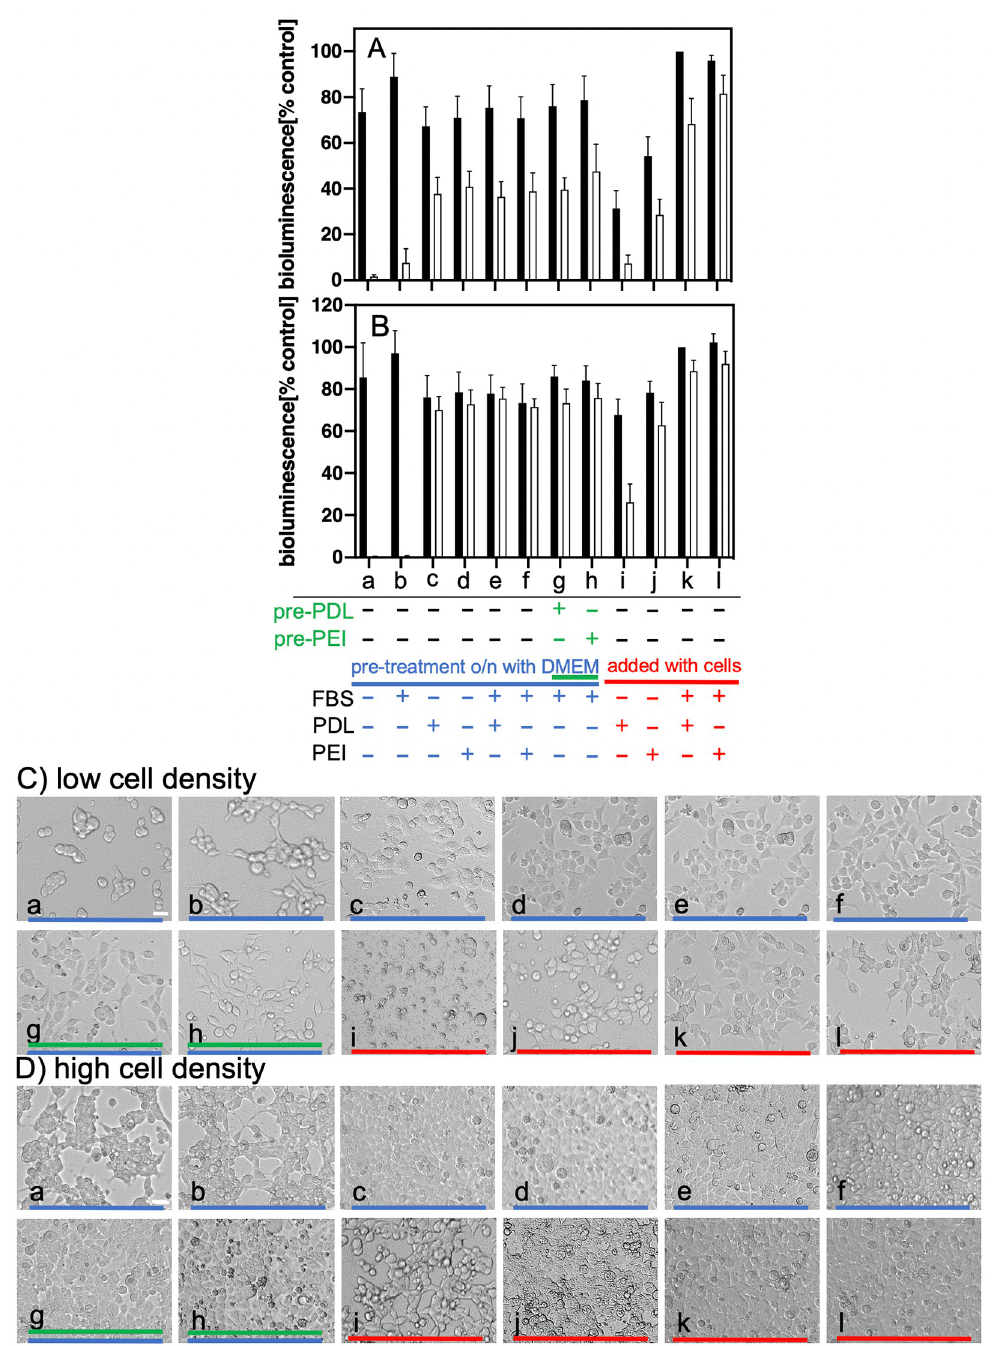
Fig 5. Fetal bovine serum not required for strong cell adhesion after PDL or PEI pre-treatment. Wells were pre-treated overnight with medium without or with addition of fetal bovine serum (FBS), PDL (2 μ g/ml), or PEI (1.5 μ g/ml) as indicated. Some wells were first pre-treated 1 h with either PDL (100 μ g/ml) or PEI (10 μ g/ml) (pre-PDL, pre-PEI; green bars). After 16 h cells were seeded either in medium only (a-h; blue bars) or in medium with addition of FBS, PDL, or PEI as indicated (i-l; red bars). The next day, cell attachment was determined as described in “Materials and methods”. A) and C), cell densities < 50.000 cells/well (subconfluent next day); B) and D), cell densities > 80.000 cells/well (confluent next day). The columns represent Mean ± SEM (n � 6, performed in duplicates); (black) control, (white) rinsed. The wells with addition of FBS and PDL but without rinsing were taken as 100%. C) and D) representative phase-contrast images taken for low and high cell densities, respectively (white bar = 20 μ m). Small letters and coloured bars refer to the column pairs and their conditions as outlined below Fig A and B.